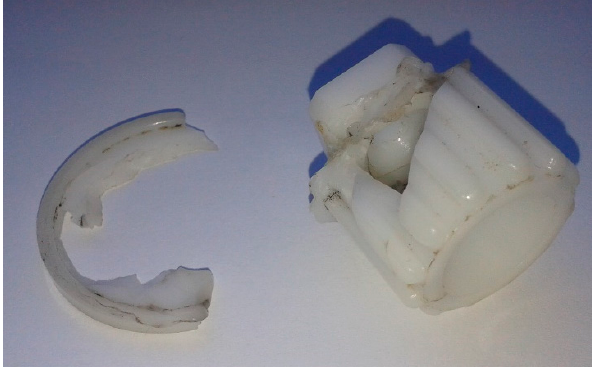
Figure 1. Broken grooved shaft–plastic material/part.